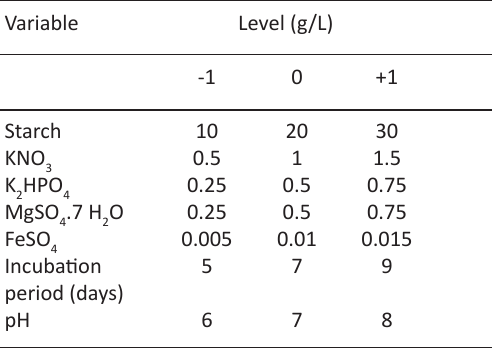
Table 1. Levels of independent variables in the Plackett- Burman experiment Variable Level (g/L)